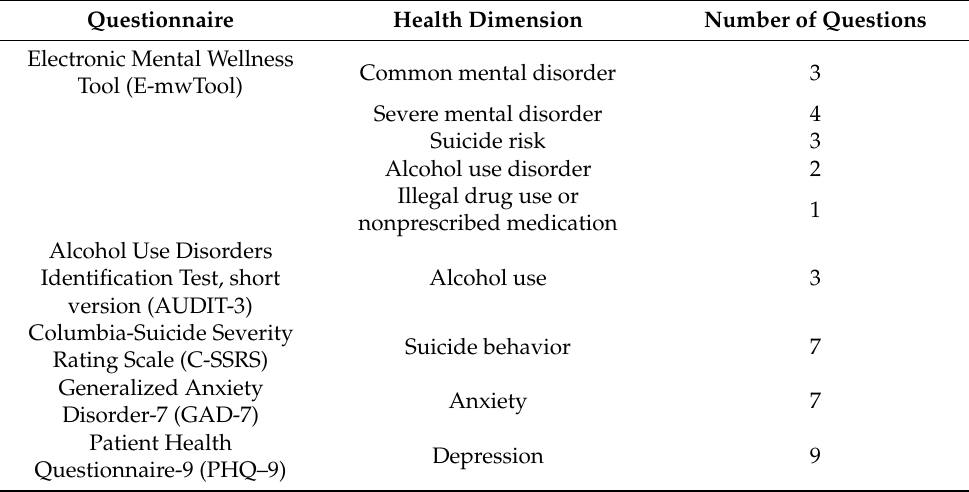
Table 1. Health dimensions and the number of questions of E-mwTool and self-administered ques-